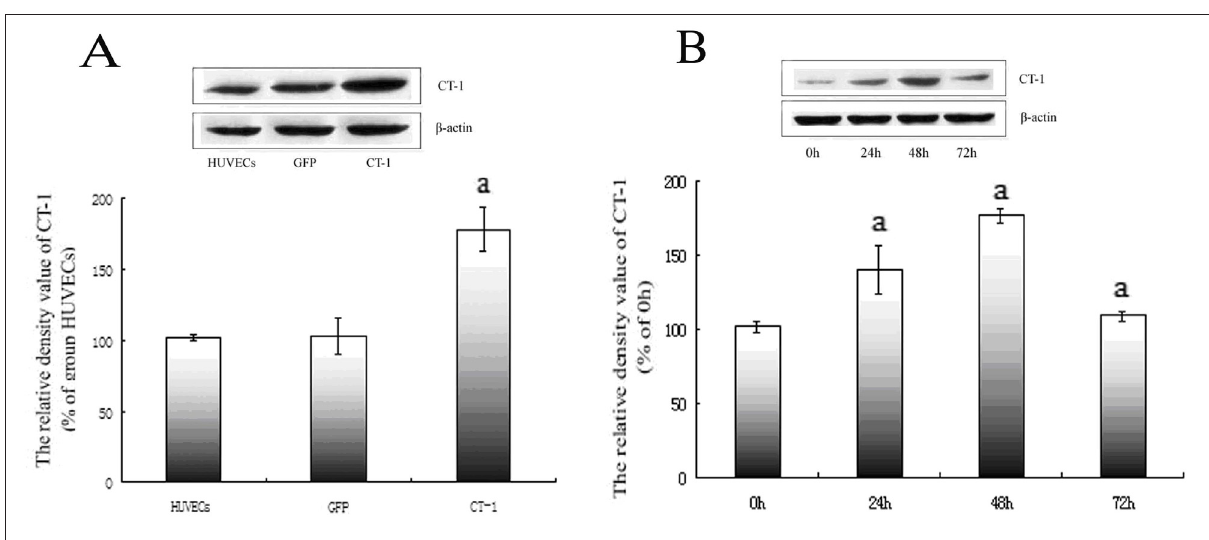
Fig. 2. Western blot analysis of the expression of CT-1. β-actin was used as an internal control to monitor equal protein sample loading. (A) Expression of CT-1 after transfection at 48 h. (B) Expression of CT-1 after transfection at different times. a